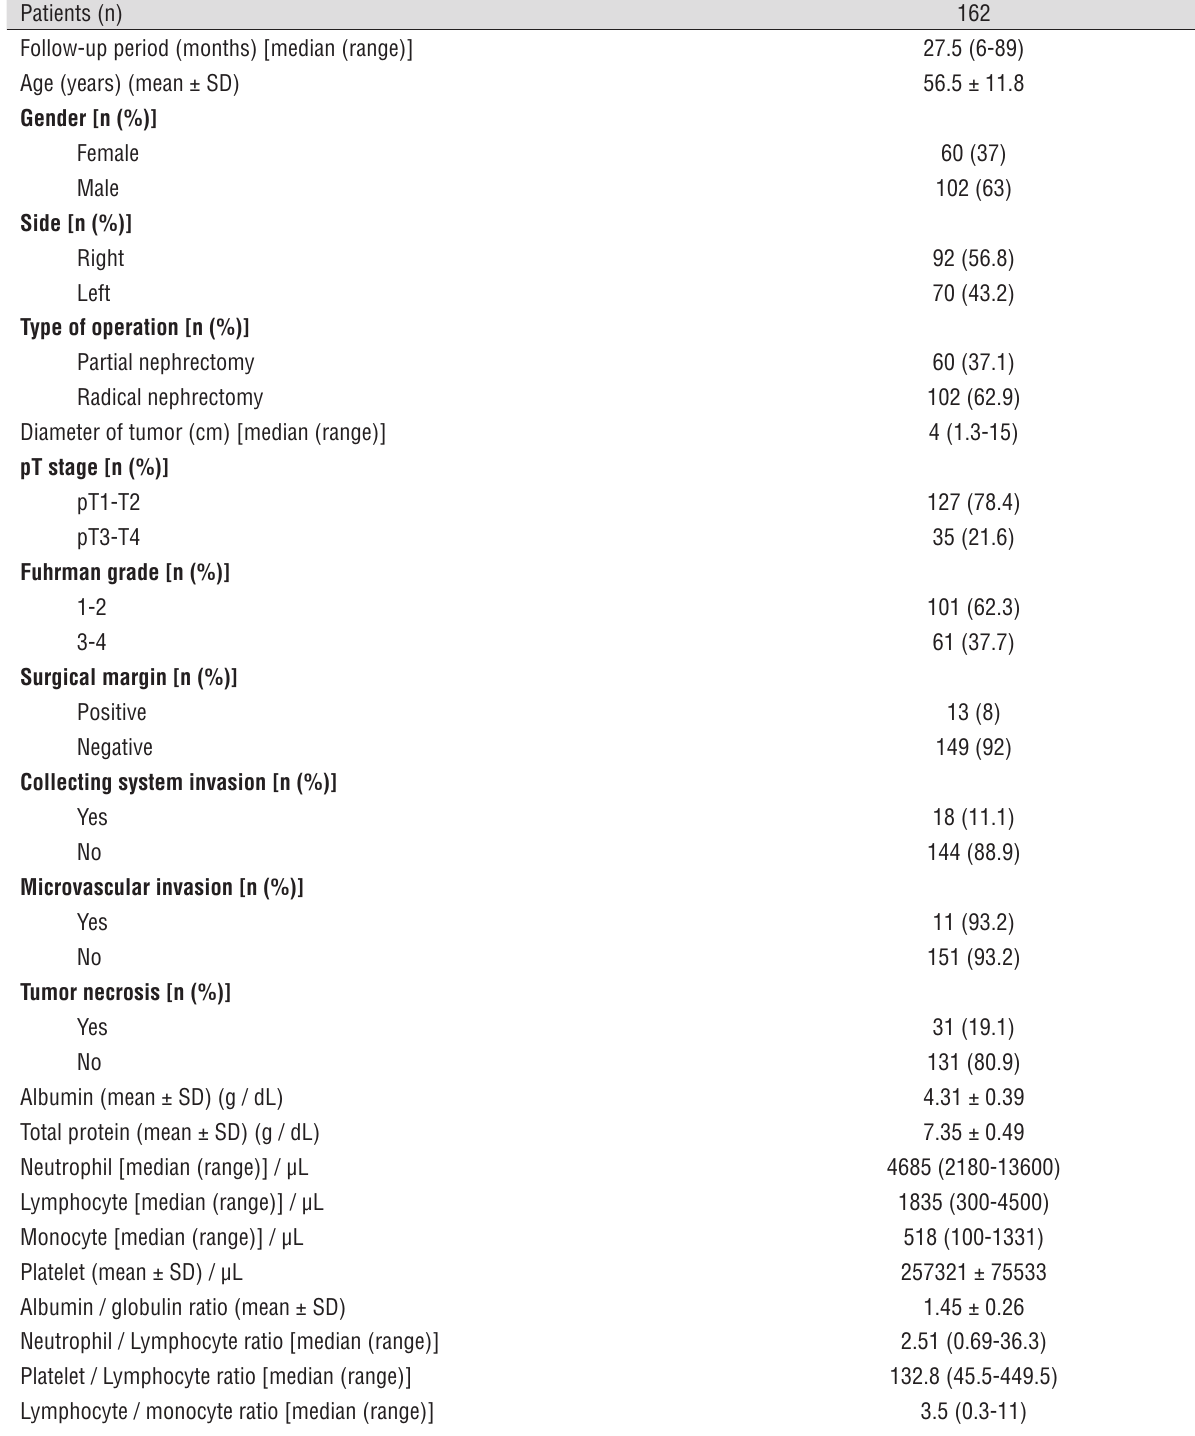
Table 1 - Clinicopathological